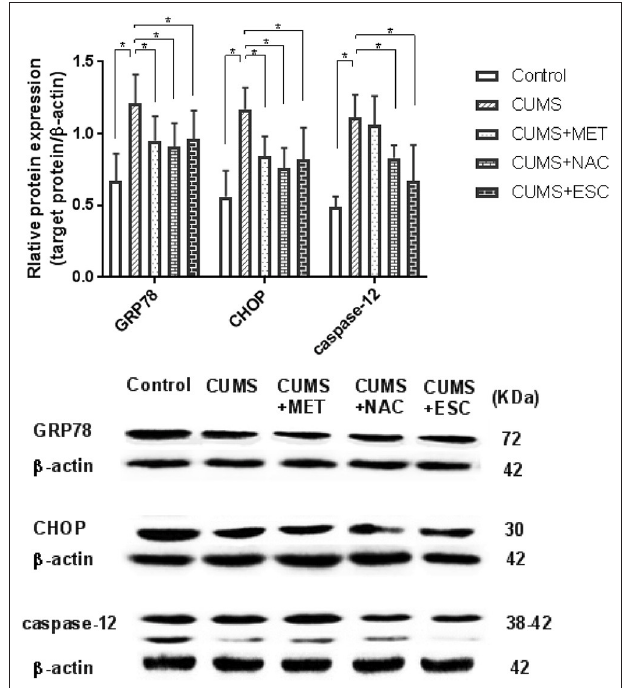
FIGURE 6 | Effect of MET, NAC, and ESC on the protein levels of ERS markers in CUMS-induced rats. * P < 0.05 (one way ANOVA), n = 9.